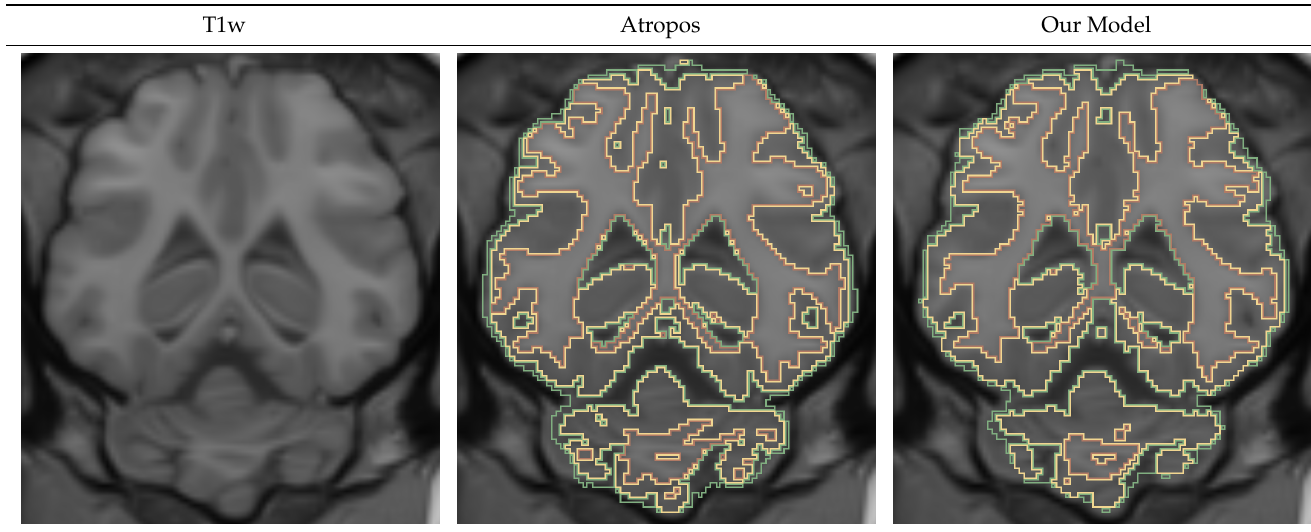
Figure 5. Gray and white matter and cerebrospinal fluid segmentation mask visualization. Our model produced masks similar to the Atropos tool.